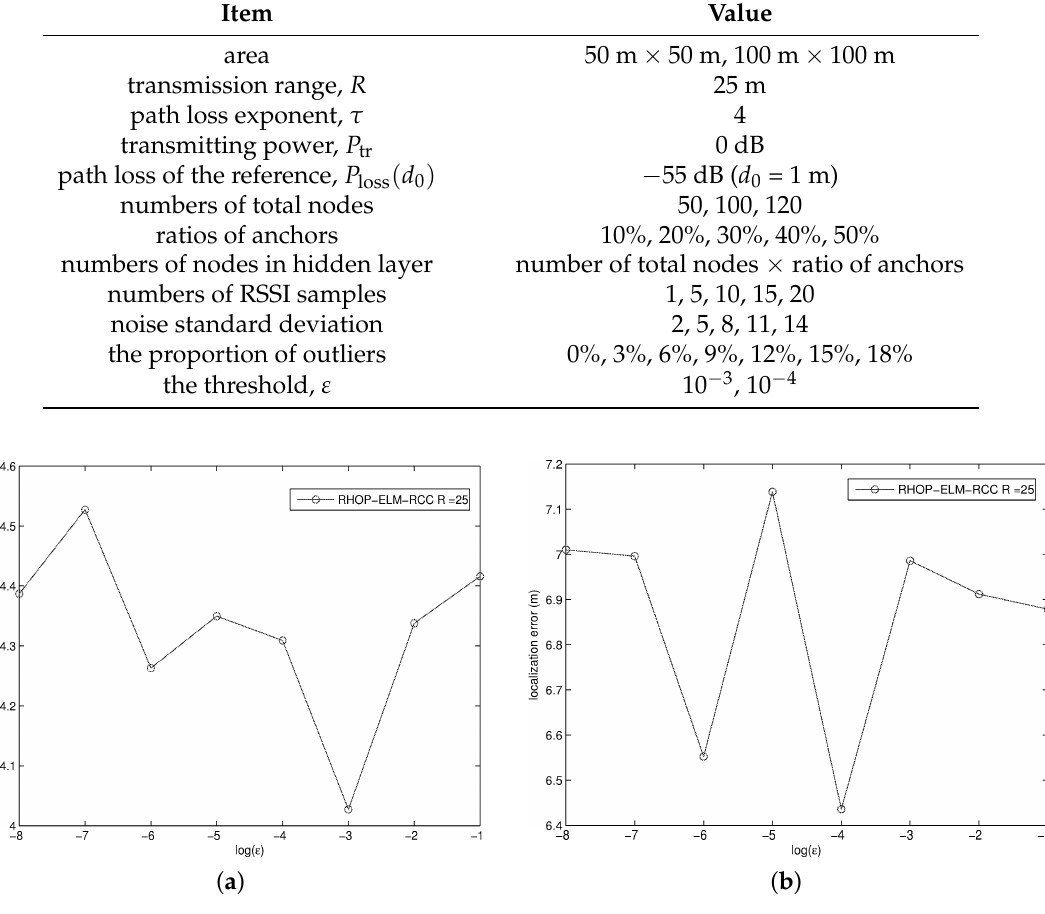
Figure 4. The impact of ε in different areas when R = 25. ( a ) The average ε in the area of 50 m × 50 m when R = 25; ( b ) The average ε in the area of 100 m × 100 m when R =